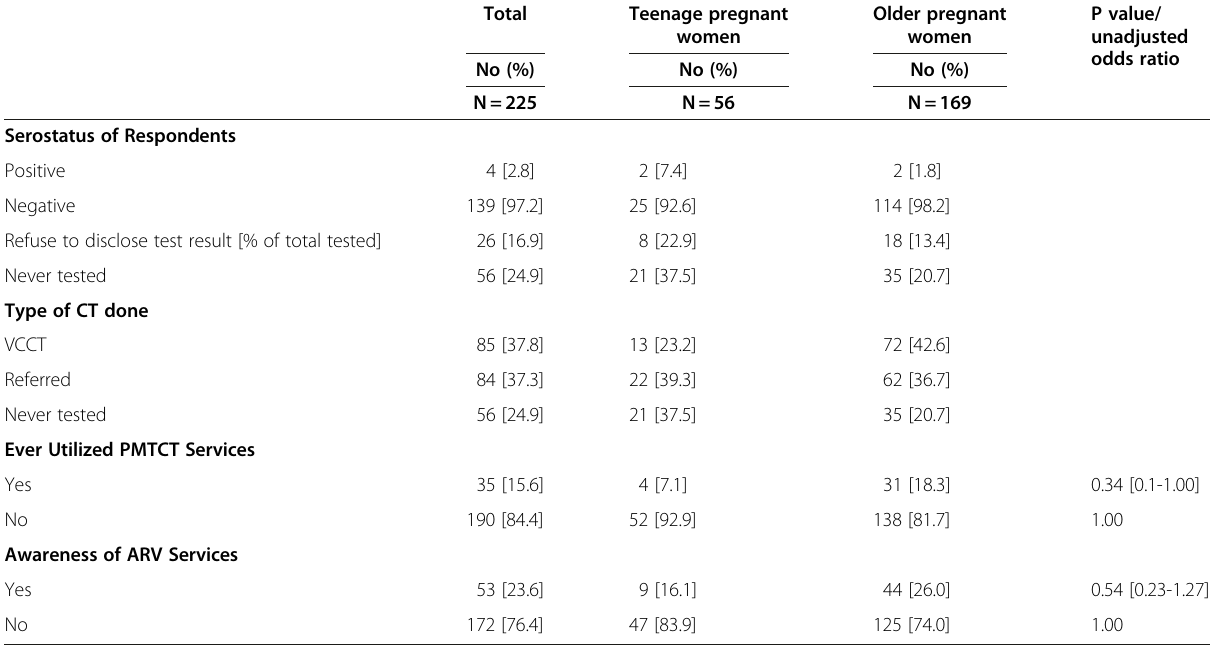
Table 3 Utilization of PMTCT services by respondents